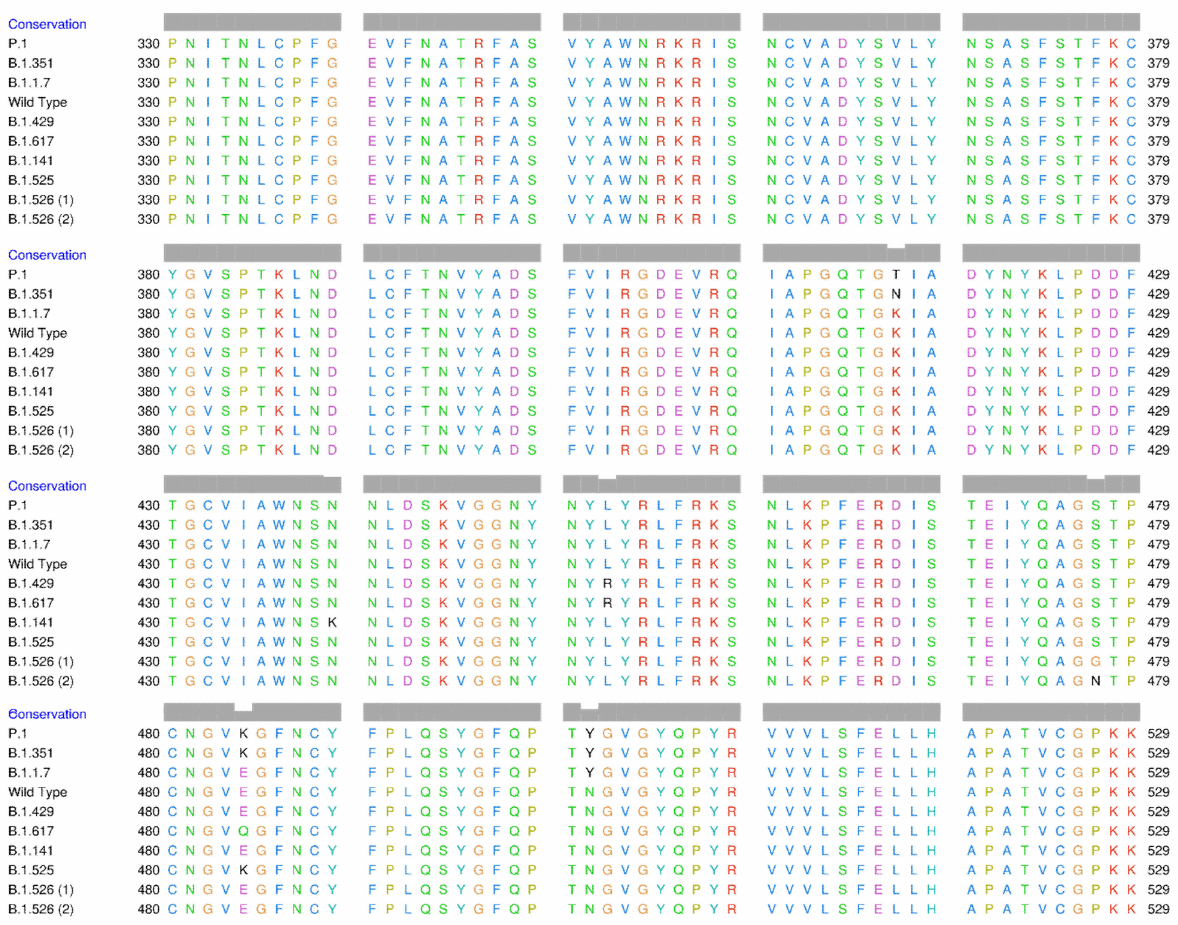
Figure 1. The genomic structure of the S glycoprotein of SARS-CoV-2 showing the position of each gene and the impactful mutations in the RBD.